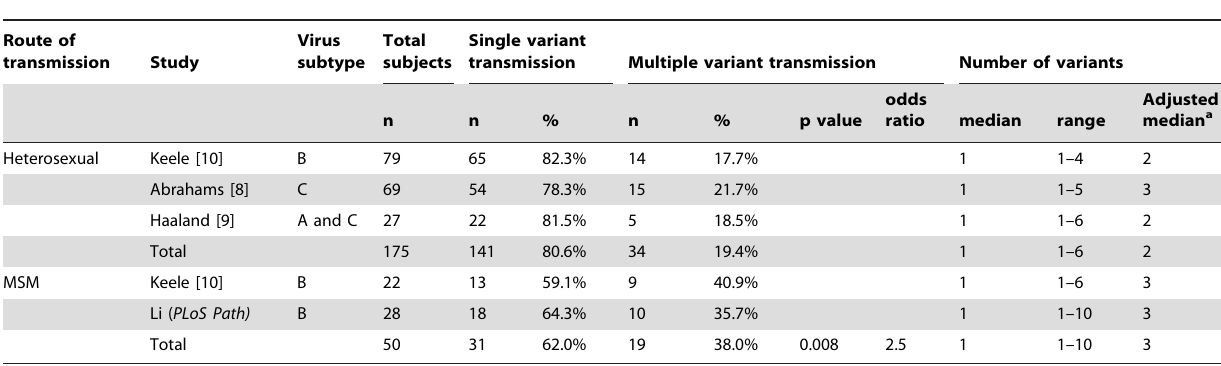
a Adjusted median values are for multivariant transmissions only.